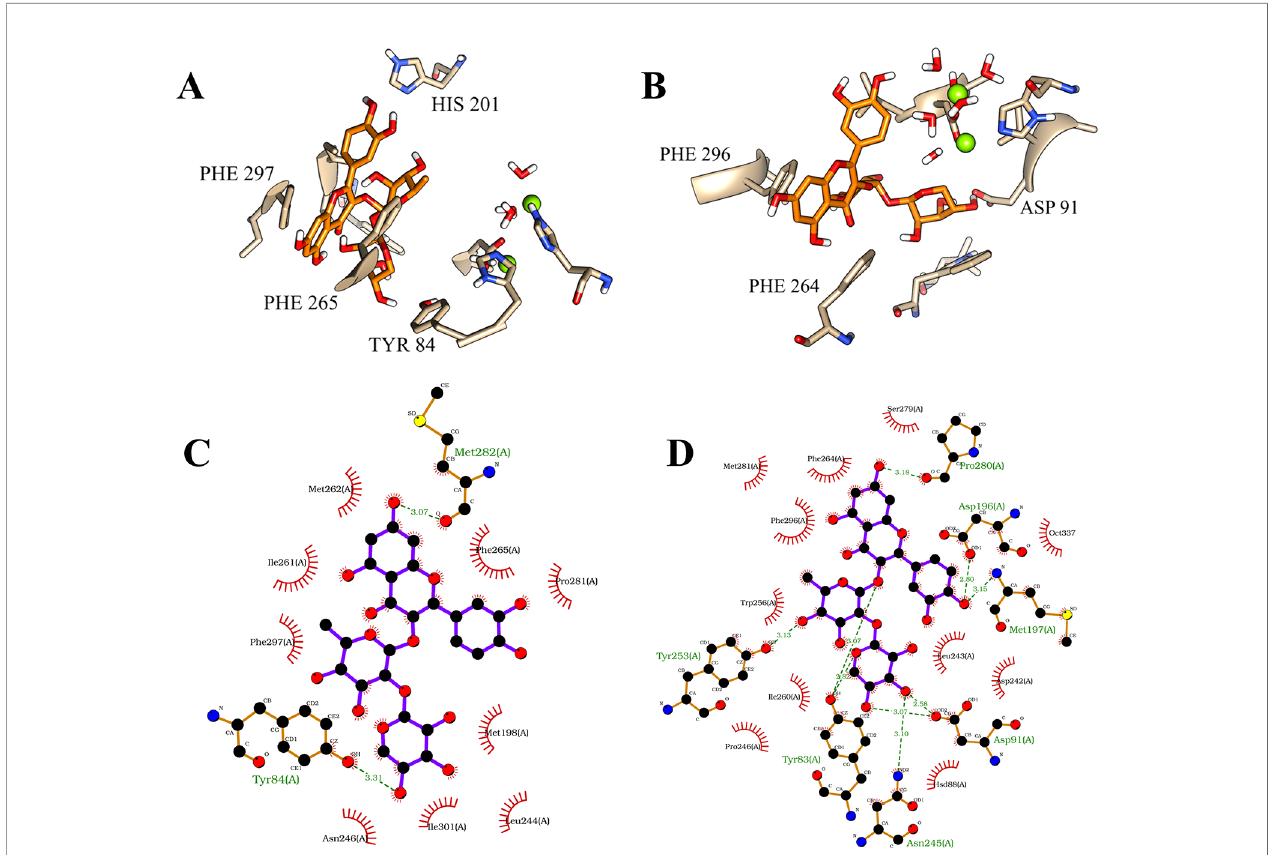
FIGURE 4 | Illustration of interactions between compound 1 (orange) and the amino acid residues of PDE4A (A) and PDE4B (B) for the fi rst pose. 2D representation of the intermolecular interactions between the compound 1 and PDE4A (C) and PDE4B (D) . The 2D diagrams was provided by the program